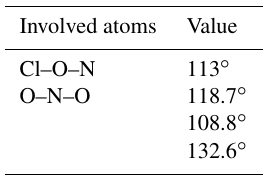
Table 1. Bond angles of ClONO 2 , from Rankin and Robertson (1994).